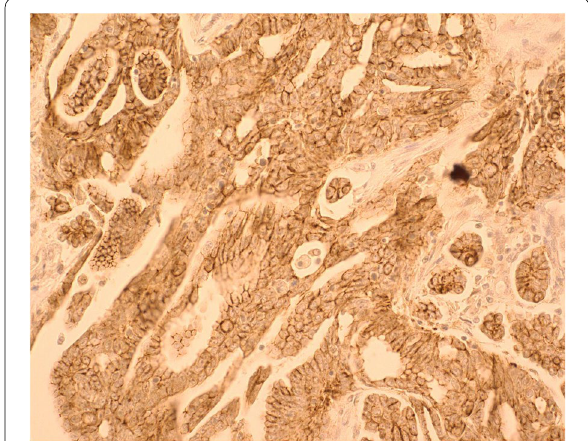
Fig. 3 CLDN4 expression in low‑grade ovarian serous carcinoma. There is membranous expression and notable cytoplasmic expression.